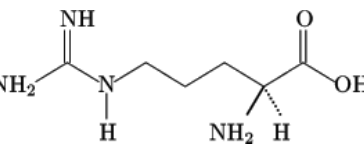
Figure 3. Variation of sorption of Co(II) on the wool samples depending on the initial bath concentration measured 100 days after the irradiation.